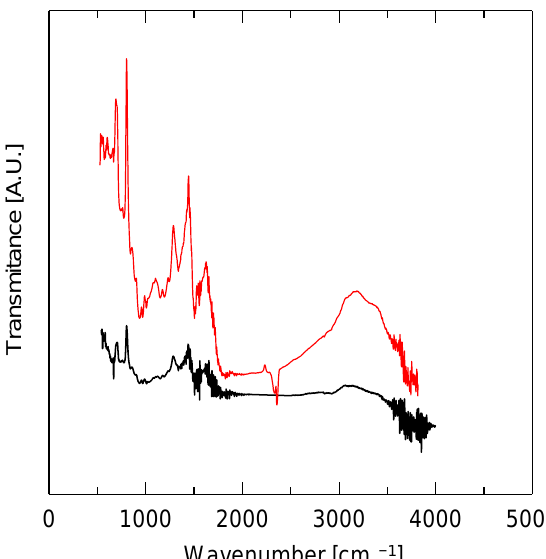
Membranes 2023 , 13 , x FOR PEER REVIEW